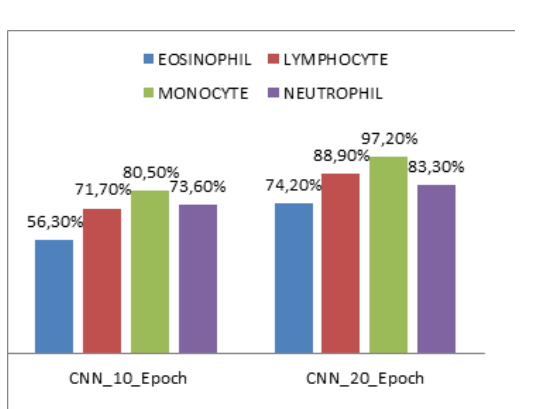
Figure 3. Sensitivity of the four types for CNN with 10 and 20 epochs